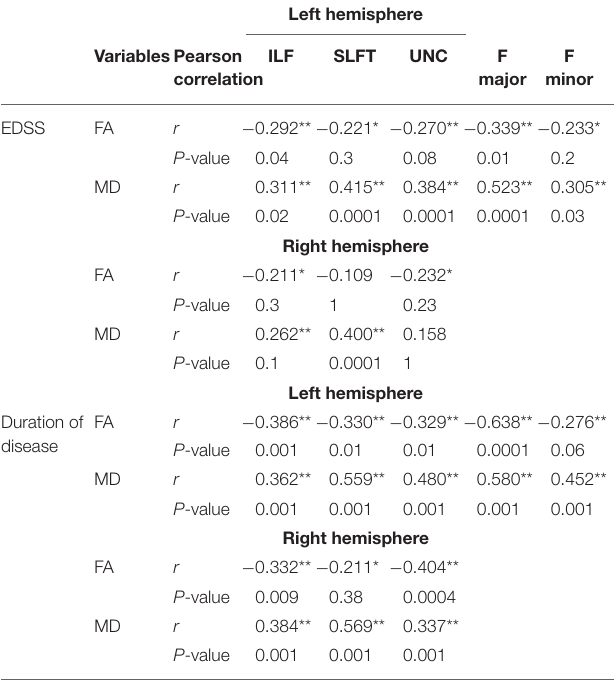
TABLE 2 | Spearman correlation analysis between FA and MD in tracts that changed significantly in the study with EDSS scores. Left hemisphere VariablesPearson ILF SLFT UNC F F correlation major